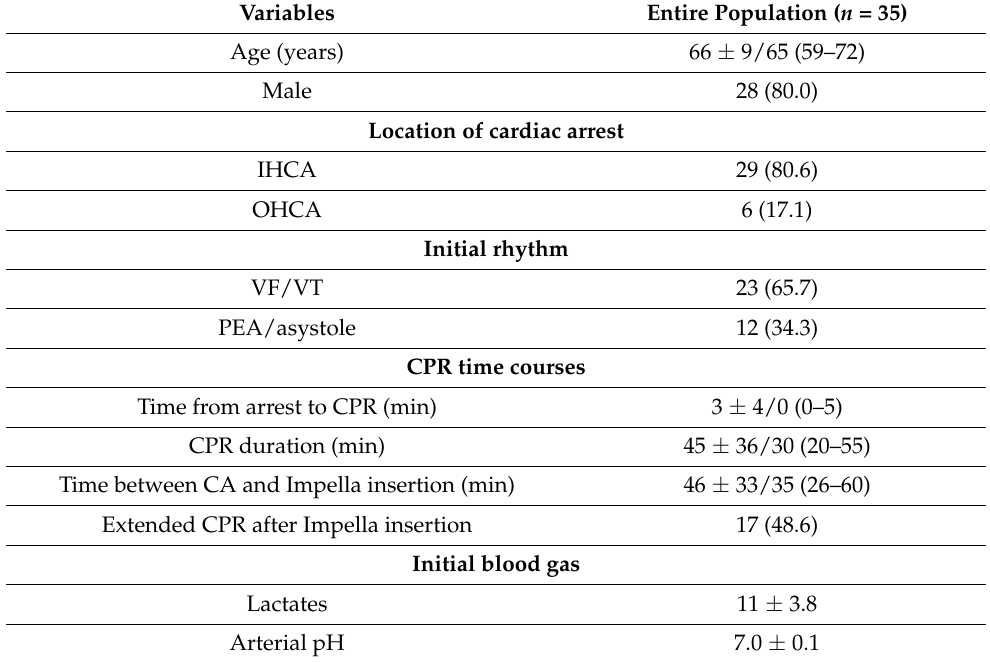
Table 1. Characteristics of the